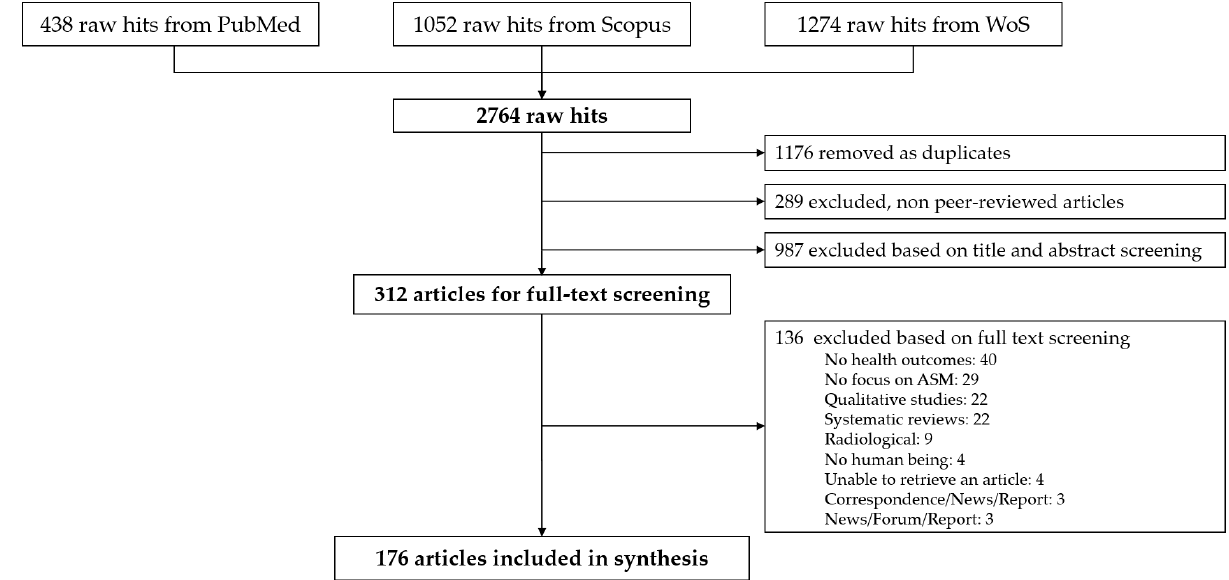
Figure 1. Preferred Reporting Items for Systematic reviews and Meta-Analyses (PRISMA) flow chart indicating the number of articles that were searched in PubMed, Scopus, and Web of Science (WoS), screened, and included in the current scoping review (ASM, artisanal and small-scale mining).